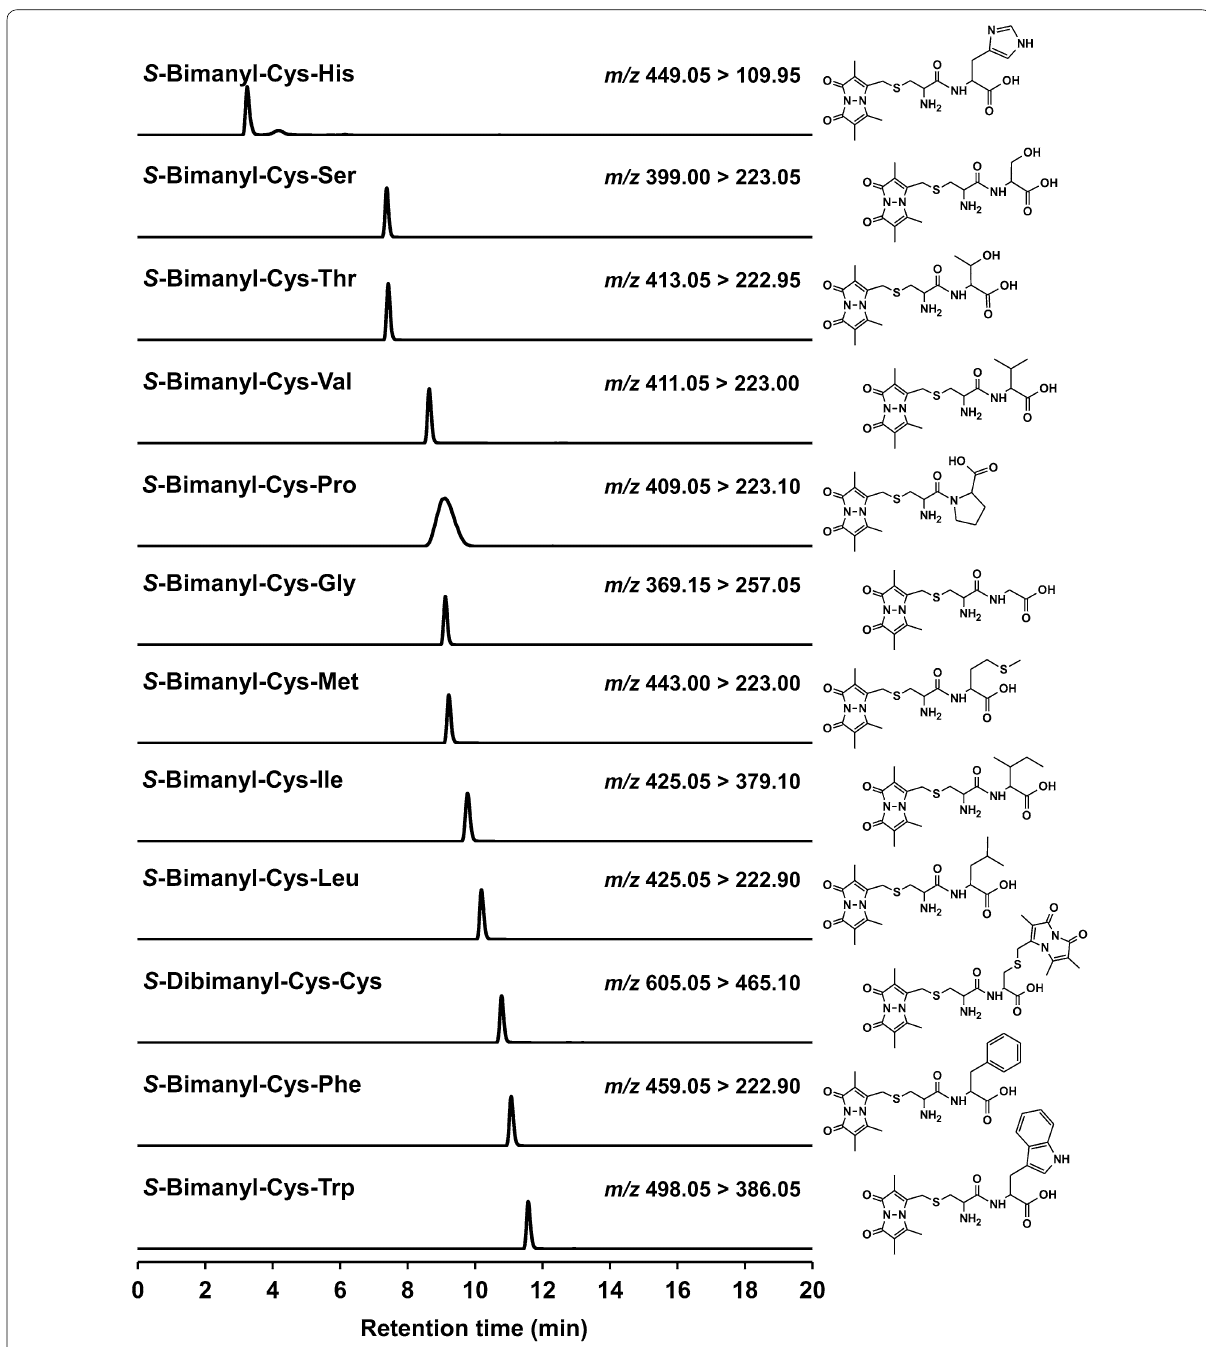
Fig. 2 Mass chromatograms of cysteine-containing dipeptide authentic standards derivatized with monobromobimane. The y-axis (not shown) represents normalized intensity of ion count in the mass chromatogram monitoring m/z characteristic of individual target compounds, x-axis represents time in the analysis (0–20 min). The m/z transitions and structural formulae of each S -bimanyl derivative are indicated in the